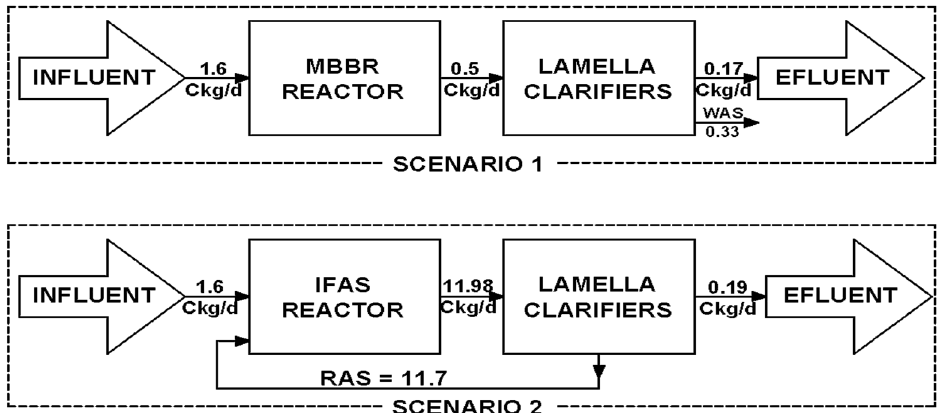
Figure 3. Mass balance based on carbon around bio-treatment unit for both scenarios.